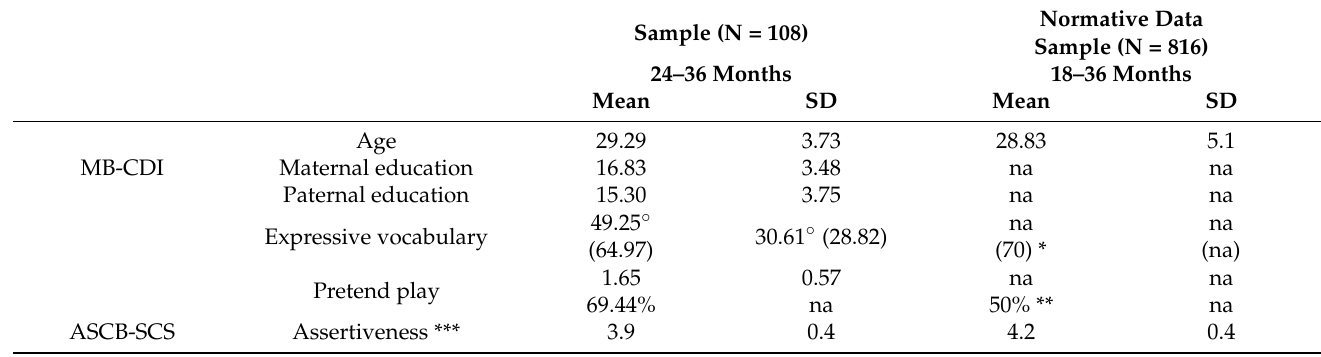
Table 1. Demographic and cognitive characteristics of the children included in the study. Data are expressed as means and standard deviations, or percentages. Legend: SD—Standard Deviation; SCS: Socio-Conversational Skills; EFs—Executive Functions; na—Not available. * MB-CDI (MacArthur Bates Communicative Development Inventory) raw mean retrieved from normative data of children at the median age (29 months). ** MB-CDI percentage of parents reporting their children often do pretend play activities; the percentage is retrieved from scores of children at the median age (29 months). *** ASCB (Abilit à Socio-Conversazionali del bambino) normative data are retrieved from 24-months children. **** BRIEF-P (Behaviour Rating Inventory of Executive Functions, Preschool version [26]) normative data are retrieved from 58 (27 males) 24–36